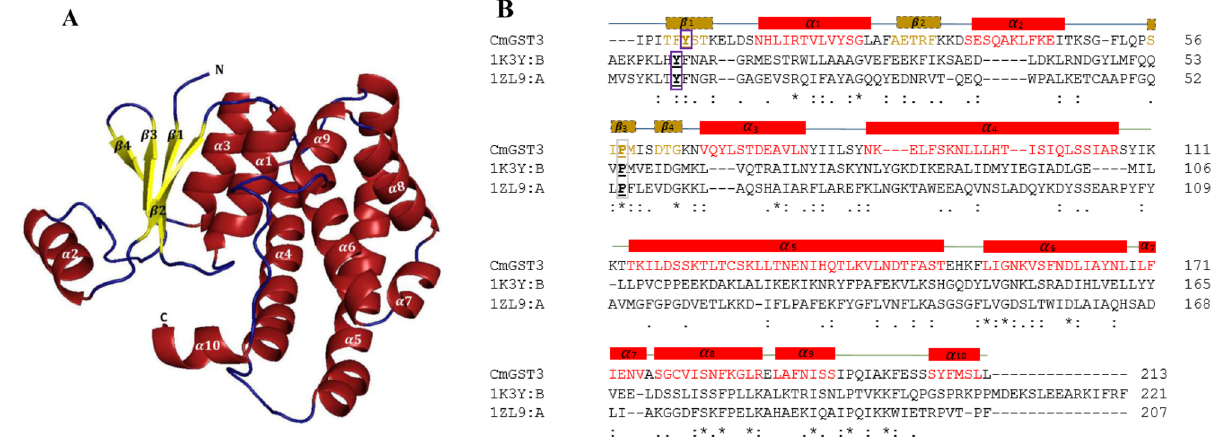
Figure 5. In silico structural analysis of Psi class representative Cryptosporidium meleagridis strain UKMEL1 GST3 glutathione transferase 3 (C p GST3). 3D model of C m GST3 ( A ) and its amino acid sequence alignment with templates ( B ). Secondary structural annotations were done as per modeled structure where α-helices and corresponding amino acids are colored in red while the β-sheets and their corresponding amino acids are colored in yellow. The active-site tyrosine and the cis -proline residues are boxed in purple and grey respectively. The template Protein Data Bank codes, 1K3Y-B and 1ZL9-A, represents GST protein crystal structures from Human (Alpha class GST) and Caenorhabditis elegans (Pi class